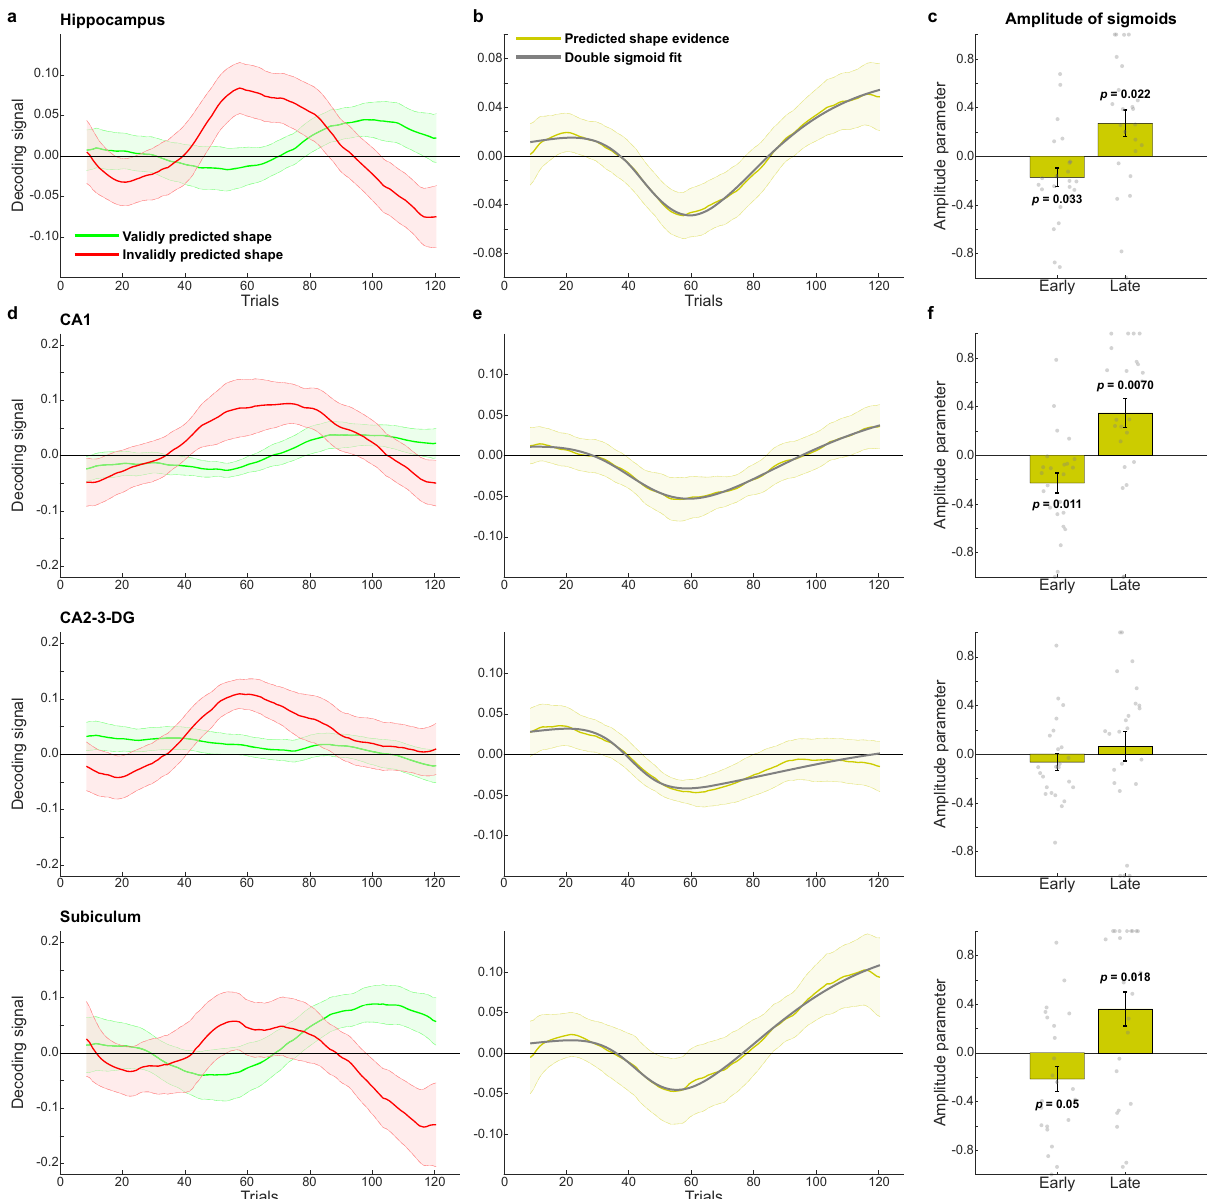
Fig. 5 Experiment 2 shape decoding over trials. a Decoding evidence for validly (green) and invalidly (red) predicted shapes in the hippocampus. b Decoding evidence for predicted (valid – invalid) shapes in the hippocampus (yellow) with the double sigmoid fi t (grey). c Amplitude parameters of early (midpoint between trials 1 and 64) and late (midpoint between trials 65 and 128) sigmoid curves in the hippocampus. P value re fl ects two-sided one- sample t -test against zero. d Decoding evidence for validly (green) and invalidly (red) predicted shapes in hippocampal sub fi elds. e Decoding evidence for predicted (valid – invalid) shapes in hippocampal sub fi elds (yellow) with the double sigmoid fi t (grey). f Amplitude parameters of early (midpoint between trials 1 and 64) and late (midpoint between trials 65 and 128) sigmoid curves in hippocampal sub fi elds. Time courses were temporally smoothed using a sliding window approach (see Methods for details). N = 24 participants in all panels. Shaded regions and error bars indicate SEM. Dots indicate individual participants. P values re fl ect two-sided one-sample t -tests (df = 23) against zero. Source data are provided as a Source Data fi